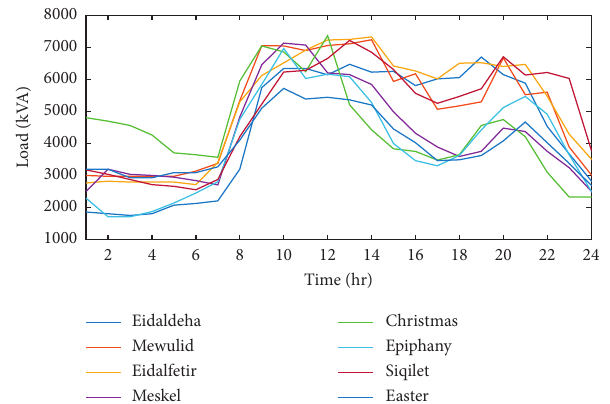
Figure 3: Hourly load profile of religious holidays in 2019/20.